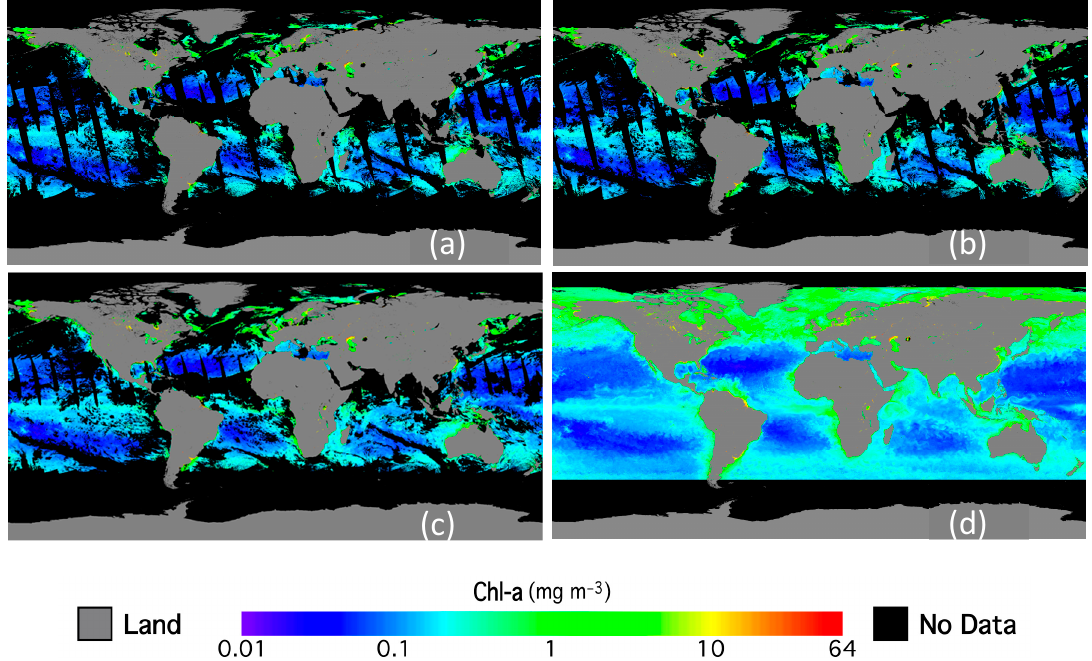
Figure 1. The Visible Infrared Imaging Radiometer Suite (VIIRS)-measured global Level-3 Chl-a image on 21 June 2018 from ( a ) Suomi National Polar-Orbiting Partnership (SNPP), ( b ) National Oceanic and Atmospheric Administration (NOAA)-20, ( c ) merged VIIRS SNPP/NOAA-20 Chl-a image on the same day, and ( d ) gap-filled VIIRS SNPP/NOAA-20 merged Chl-a image on the same day.